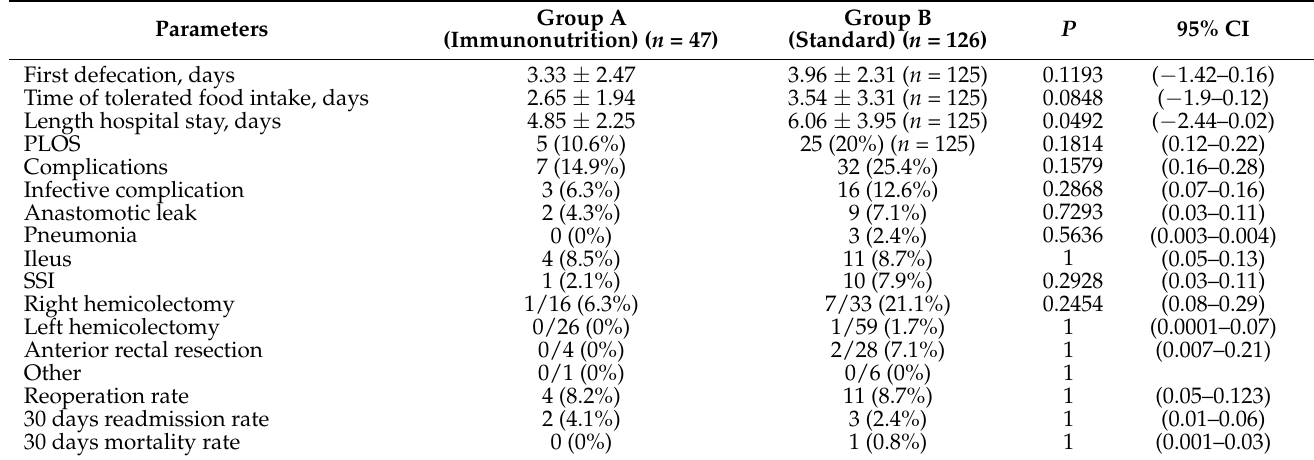
Table 5. Results of primary and secondary